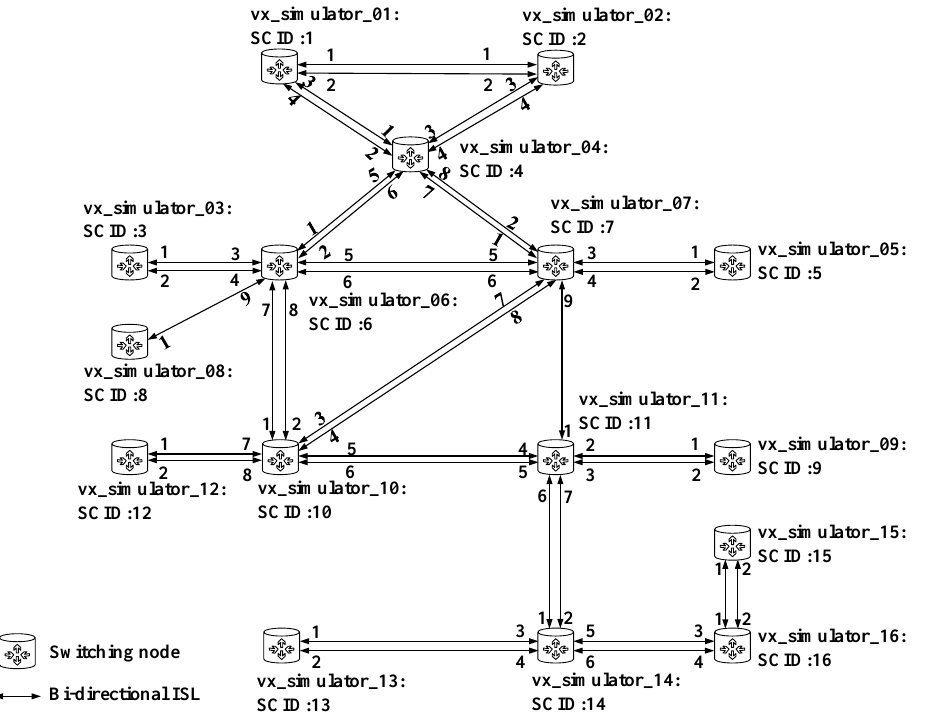
Figure 8. The topology of VxWorks simulated network. Table 1. The routing path of managing and controlling messages between node vx_simulator_01 (SCID 1) and node vx_simulator_03 (SCID